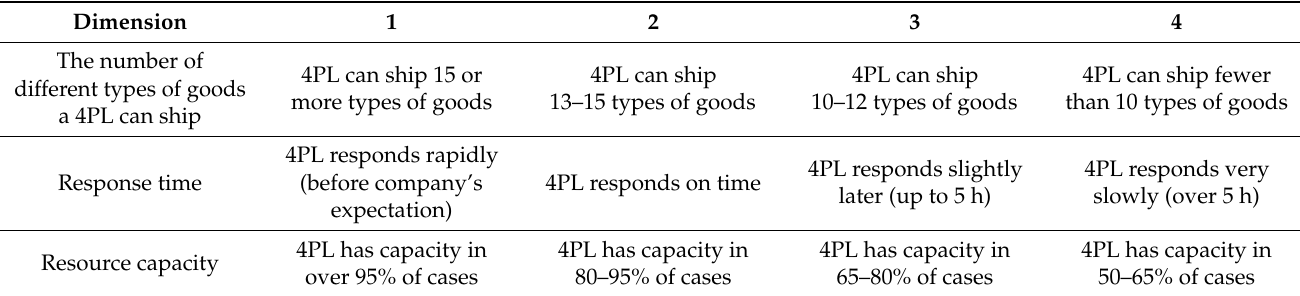
Table 2. Assessment scale for flexibility